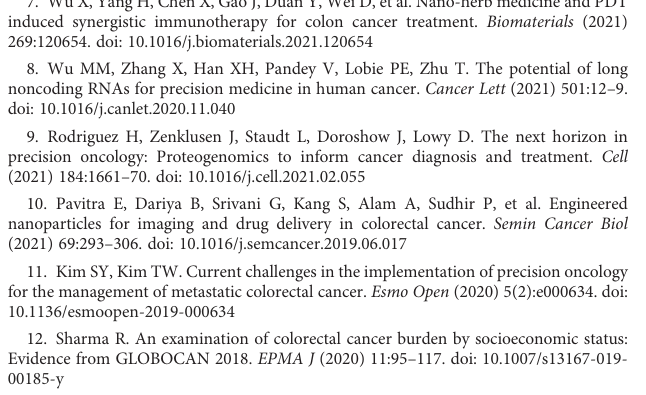
SUPPLEMENTARY FIGURE 1 Mulberry plot of clinical information of patients with colon cancer. SUPPLEMENTARY FIGURE 2 Survival analysis of patients. (A) : Survival analysis of ULBP1 in low-, medium-, and high-expression subgroups of ULBP1. (B) : Survival analysis of patients with colon cancer at different ages. (C) : Survival analysis of colon cancer patients with different clinical stages. SUPPLEMENTARY FIGURE 3 Immunohistochemical staining of ULBP2 in two normal colon tissues (source: Human Protein Atlas; www.proteinatlas.org). SUPPLEMENTARY FIGURE 4 The importance of six eigenvalues in distinguishing 3-year survival. SUPPLEMENTARY FIGURE 5 Enrichment analysis of molecular function (A) and KEGG pathways (B) of DENRGs SUPPLEMENTARY FIGURE 6 Tumor mutation burden in the low-risk group vs high-risk